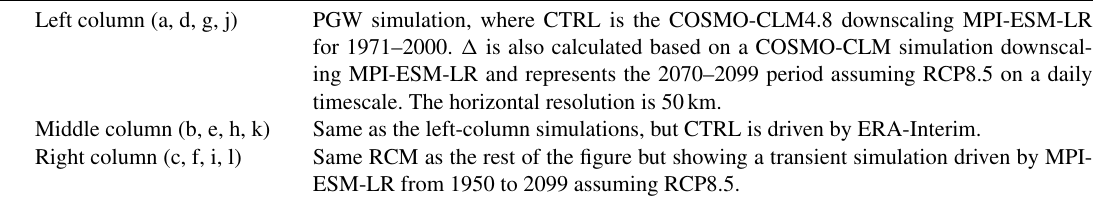
Figure Simulation/panel Properties Figure 1 (a) The RCM is COSMO-crCLIM (Leutwyler et al., 2017) at a horizontal resolution of 50km. The driving data are the ERA-Interim reanalysis (Dee et al., 2011). Figure 1 (b) The same RCM as above but using PGW. Initial and boundary conditions from ERA- Interim are modified based on the climate change signal from a transient COSMO- CLM4.8 (Rockel et al., 2008) simulation, dynamically downscaling MPI-ESM-LR (Stevens et al., 2013). The climatic change is representative of the difference between 1971–2000 and 2070–2099 assuming RCP8.5 on a daily timescale. Figure 4 All panels (cid:49) SST is given by the GCM MPI-ESM1-2-HR (Gutjahr et al., 2019) representing the change between 1985–2014 and 2070–2099 following the SSP5-8.5 (Meinshausen et al., 2020) emission scenario and is shown for the month of January. The CMIP6 out- put group OMON (for ocean data) is used. The data are interpolated onto the ERA5 grid in panel b using bilinear interpolation and in panel c using Gaussian kernel-based interpolation with a kernel cutoff at 300km. Figure 5 Upper panels ERA5 data on 01/08/2006 00:00UTC averaged between 10–8 ◦ W and 10–8 ◦ S. Sim- ilarly to Fig. 4, (cid:49) is given by the GCM MPI-ESM1-2-HR representing the change between 1985–2014 and 2070–2099 following the SSP5-8.5 emission scenario and in- terpolated in time to the ERA5 time step. The CMIP6 output group AMON is used. Figure 5 Lower panels Like the upper panels, but the output group EMON is used to compute the (cid:49) . − φ Figure 5 Right panels The error in (cid:49)φ is estimated by comparing φ (cid:48) ref for a given p ref with the climate ref delta (cid:49)φ at p ref , where φ ref and φ (cid:48) are computed following Eq. (7) before and after ref applying the climate perturbation, respectively. Since the computation is performed over ocean grid points with zero surface elevation in both the GCM and the reanalysis data set, the corresponding surface pressure change p (cid:48) sfc N − p sfc (where p (cid:48) sfc N is computed following Eq. 12, and N denotes the last iteration of the pressure adjustment) should be equal to the climate delta (cid:49)p sfc which allows us to derive the error in (cid:49)p sfc as a function of p ref . Figure 6 All panels Difference between the initial conditions of two PGW simulations conducted with the RCM COSMO on 1 August 2006 00:00UTC. This means that the ERA5 files are already converted to model boundary conditions by the respective software used in COSMO. One simulation uses (cid:49) from the CMIP6 output group EMON with high ver- tical resolution, while the other one uses AMON. Besides this difference, the (cid:49) are identical to Fig. 5. Figure 7 Left column (a, c, e, g) Average of two PGW simulations using the RCM COSMO-CLM4.8. Horizontal res- olution is 50km. For one simulation (cid:49) is based on MPI-ESM-LR, for the second on HadGEM2-ES (The HadGEM2 Development Team, 2011). The changes are representa- tive of the emission scenario RCP8.5 and the difference between 1971–2000 and 2070– 2099 on a daily timescale. Figure 7 Right column (b, d, f, h) Average of two transient COSMO-CLM4.8 simulations from 1950 to 2099 assuming RCP8.5. The simulations are driven by MPI-ESM-LR and HadGEM2-ES. Horizontal resolution is 50km. The plots show the change between 1971–2000 and 2070–2099. Figure 8 Left column (a, d, g, j) PGW simulation, where CTRL is the COSMO-CLM4.8 downscaling MPI-ESM-LR for 1971–2000. (cid:49) is also calculated based on a COSMO-CLM simulation downscal- ing MPI-ESM-LR and represents the 2070–2099 period assuming RCP8.5 on a daily timescale. The horizontal resolution is 50km. Figure 8 Middle column (b, e, h, k) Same as the left-column simulations, but CTRL is driven by ERA-Interim. Figure 8 Right column (c, f, i, l) Same RCM as the rest of the figure but showing a transient simulation driven by MPI- ESM-LR from 1950 to 2099 assuming RCP8.5.